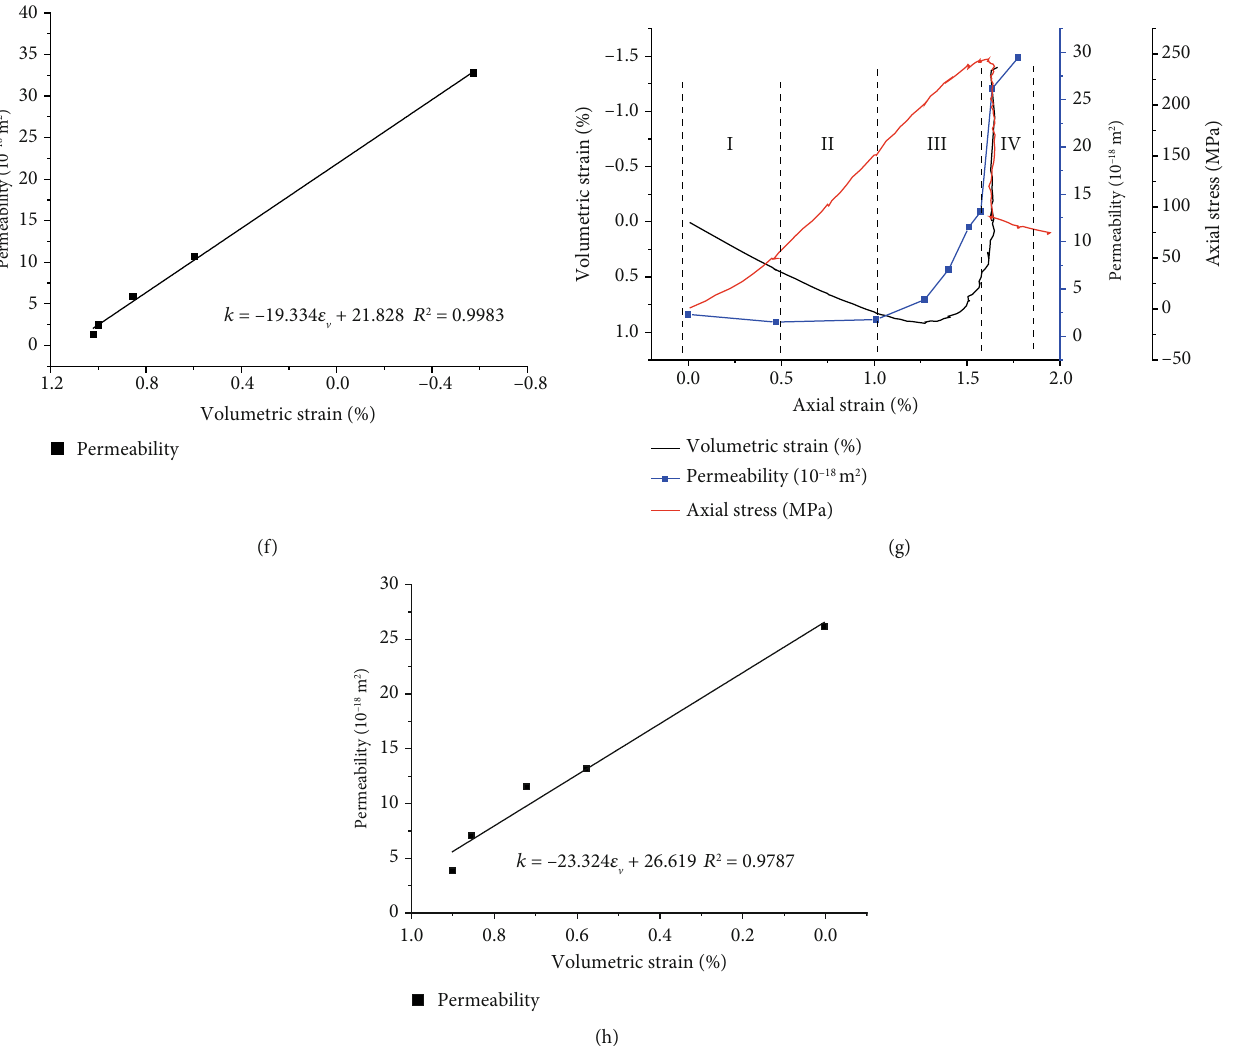
Figure 5: Permeability evolution of Beishan granite during HM coupling. (a, b) Pore pressure of 2 MPa, (c, d) pore pressure of 4 MPa, (e, f) pore pressure of 6MPa, and (g, h) pore pressure of